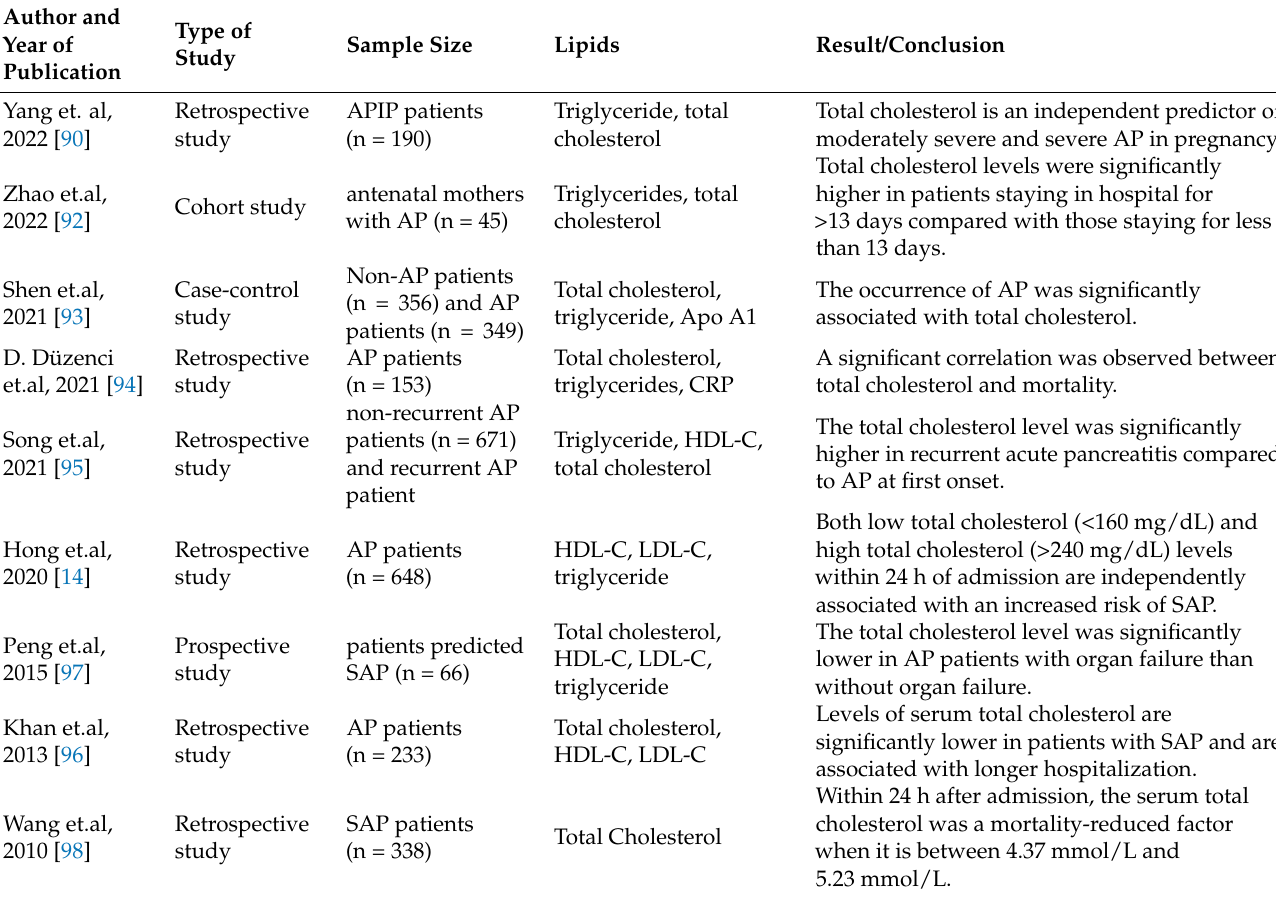
Table 1. Characteristics of included clinical studies related to the relationship between total cholesterol and